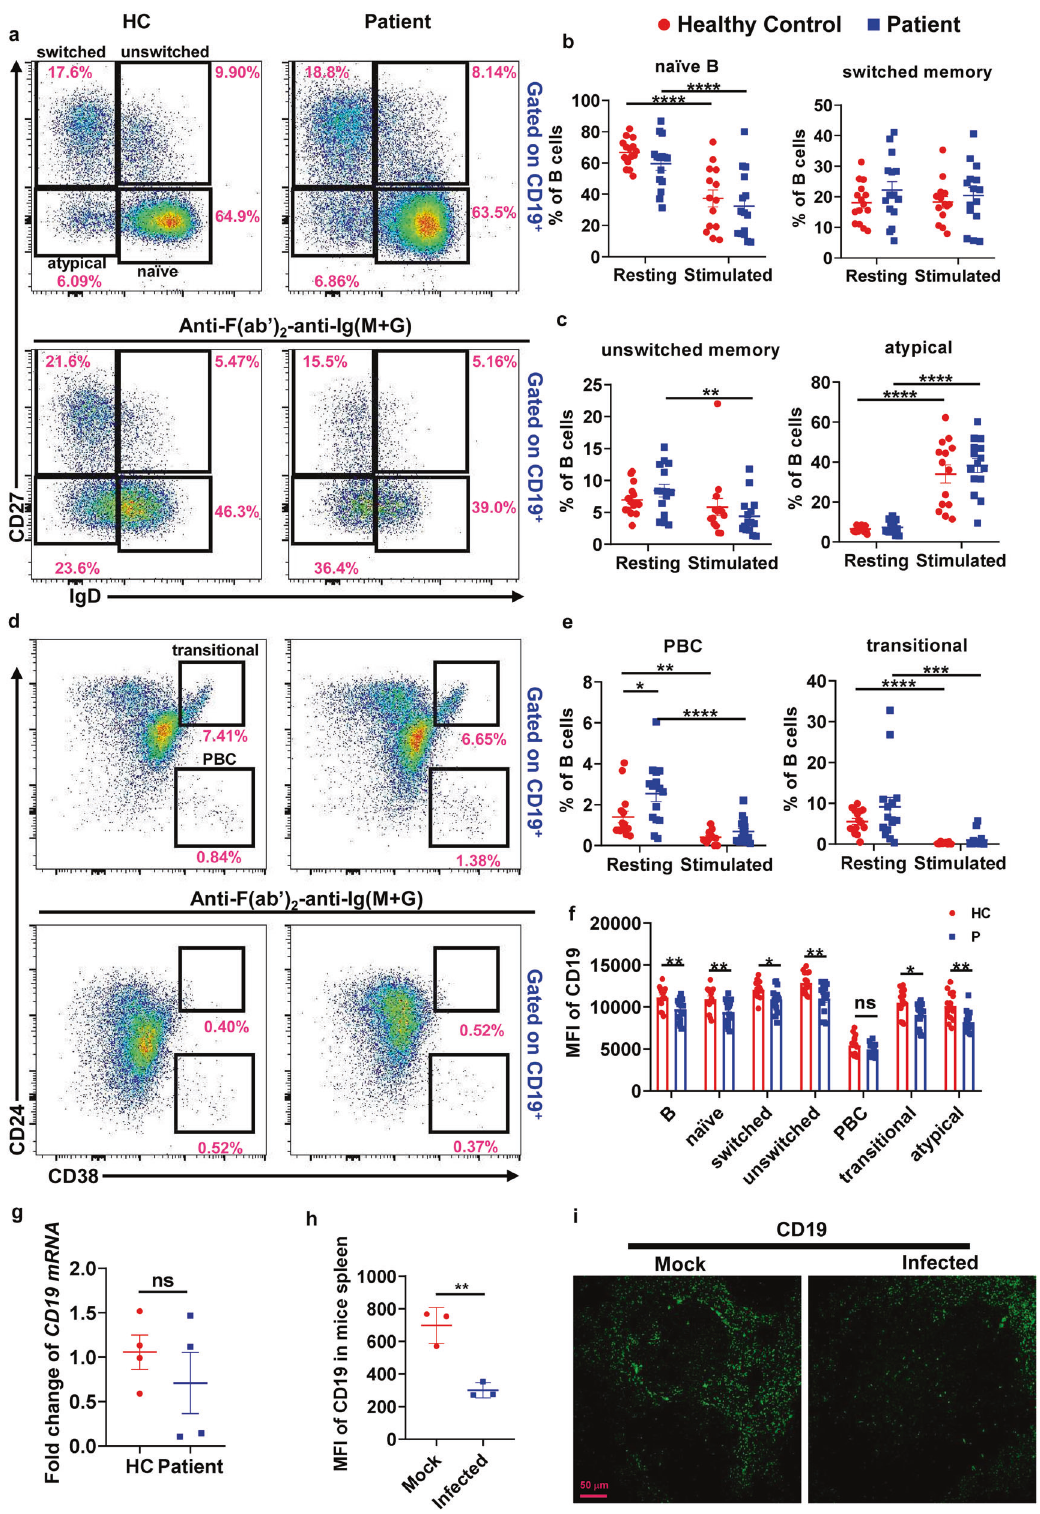
found the levels of glutamic and cysteine in serum from recovered (Fig. 3d). Among the altered metabolites, the levels of the amino COVID-19 patients were signi fi cantly decreased compared to that acids L -arginine, L -glutamic acid, L -isoleucine, L -cystine, and fi cantly reduced in the serum from recovered of healthy controls (Supplemental Fig. 1). Collectively, these results L -cysteine were signi provide a rationale to explore how serum metabolic components COVID-19 patients. To validate the results from omics data, the alter B-cell signaling and levels of glutamic and cysteine in serum were measured, and we